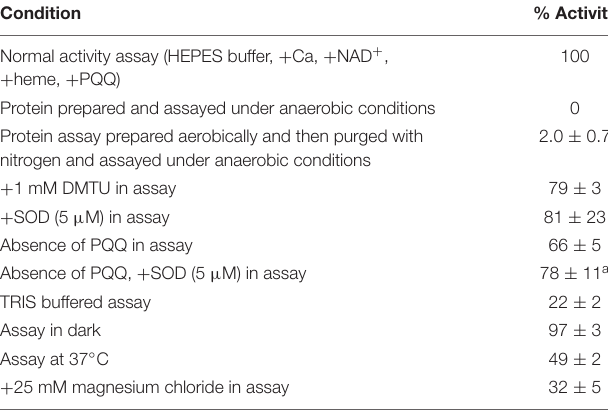
TABLE 2 | NAC purified MopA-hp